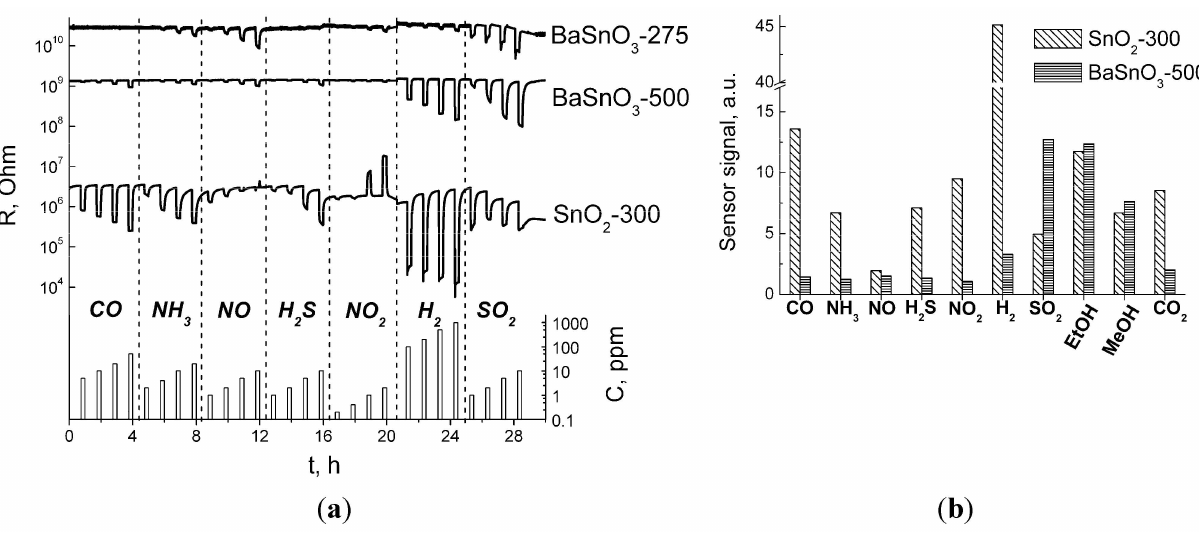
-275, BaSnO -500 and SnO -300 sensors 3 3 2 -500 and SnO -300 to target gases in air: CO (50 ppm), NH (20 ppm), 3 2 3 S (2 ppm), NO (2 ppm), H (100 ppm), SO (10 ppm), EtOH (20 ppm), 2 2 2 2 (1%); T = 300 ˝ 2